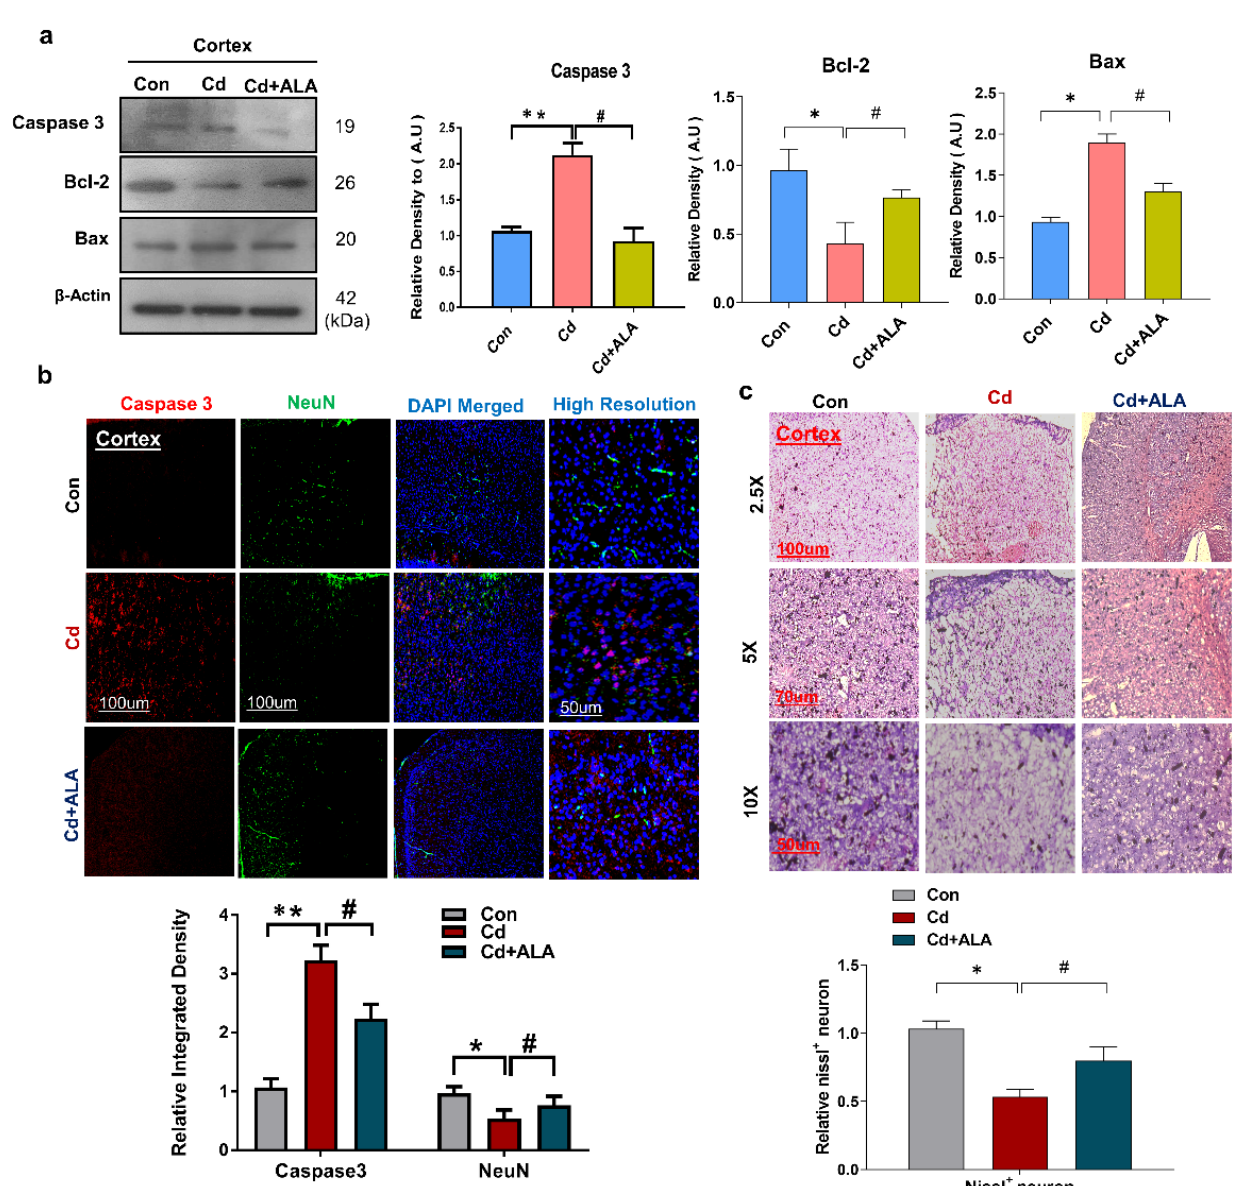
Figure 5. ALA rescue increase apoptosis in Cd-injected mice. ( a ) shows the result of a Western blot for Bax, Bcl-2, and Caspase-3 in mouse brains ( n = 5 mice per group; the number of experiments n = 3; statistical analysis of one-way ANOVA with Tukey’s posthoc test was used for comparisons among the different groups. ( b ) Double confocal images for caspase-3 and NeuN expression level, magnification 10 × , scale bar = 100 µ m and high resolution. ( c ) Immunohistochemically results of Nissl staining in the cortex, magnification 2.5 × , 5 × , and 10 × ; * significantly different from the vehicle-treated control group, # significantly different from the Cd-treated mouse group. Significance: * p < 0.05; ** p < 0.01; # p < 0.05.